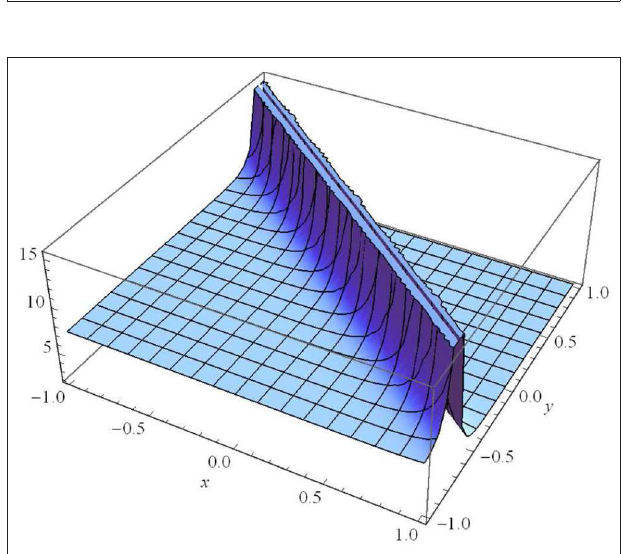
IV 8 ( x , y , t ) FIGURE 4 | 13 for m → 1: µ 1 = 1, µ 2 = 1, µ 3 = 2, α 0 = 1, β 0 = 2, λ 0 | | = 3, α 1 = 0.1, β 1 = 1, λ = 0.5, η 0 = 1, t = 0.1